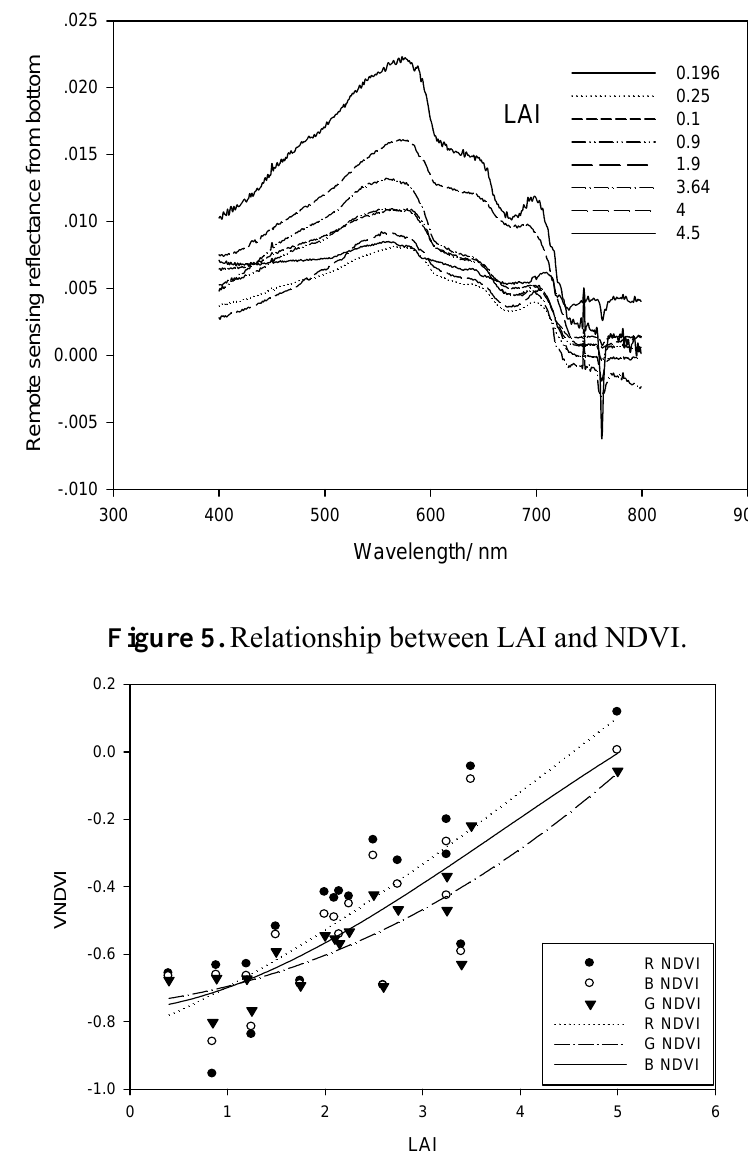
Figure 4. Relationship between spectral bands and seagrass LAI.